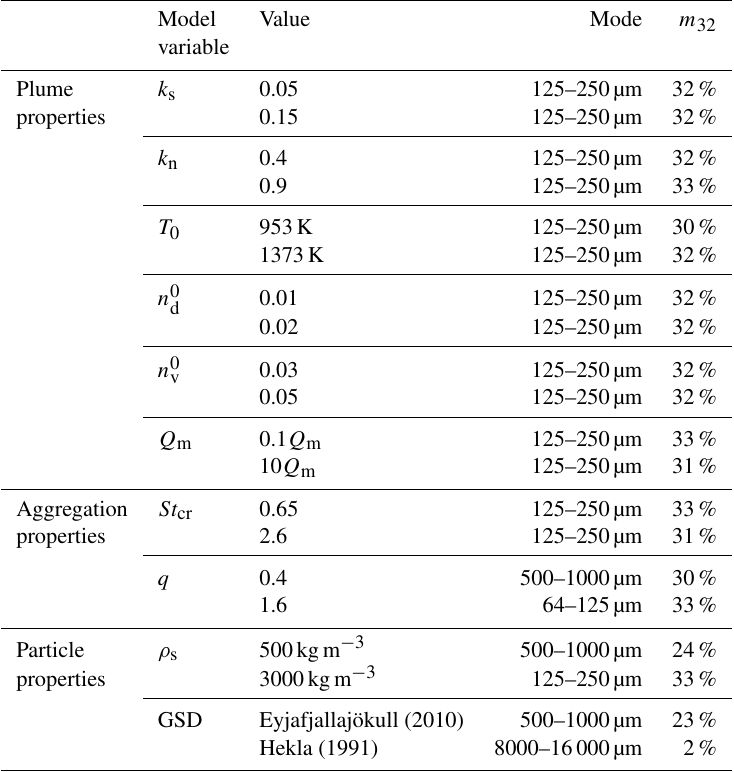
Table 4. Properties of the simulated aggregated GSD from the model sensitivity runs. The output is for 19:00UTC on 4 May 2010. Using control values (Table 3), the mode is at 125–250µm and m 32